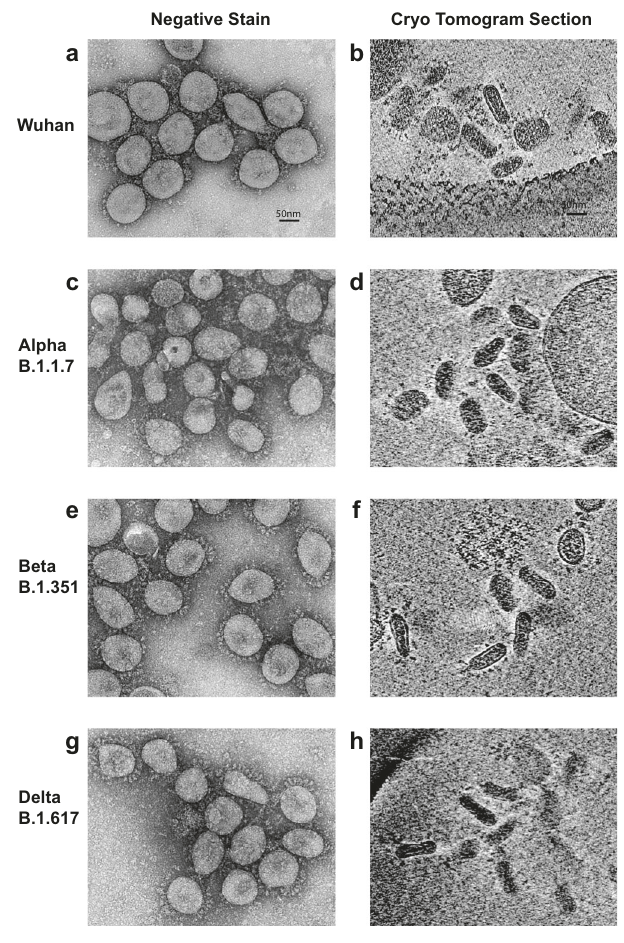
Fig. 2 Particle fi elds for Wuhan strain virus and three variants as seen in negative stain micrographs on a carbon support and in cryo-ET sections. Wuhan strain in negative stain ( a ) and cryo-ET ( b ). Alpha strain (B.1.1.7) in negative stain ( c ) and cryo-ET ( d ). Beta strain (B.1.351) in negative stain ( e ) and cryo-ET ( f ). Delta strain (B.1.617) in negative stain ( g ) and cryo-ET ( h ). The negative stain fi elds show predominantly circular views of virions, while the tomogram sections show circular, elliptical side, and oblique views. All four variants show similar virion pro fi les decorated with Spike proteins.